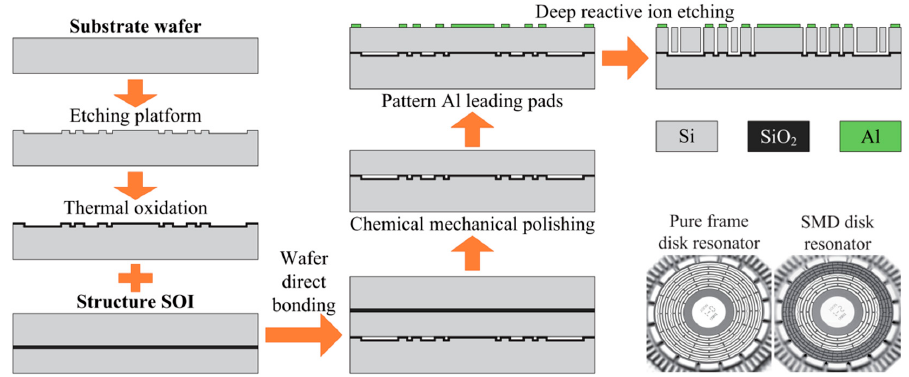
Figure 3. Fabrication process of the disk resonators. The photographs of a fabricated SMD disk resonator and a pure frame disk resonator are also